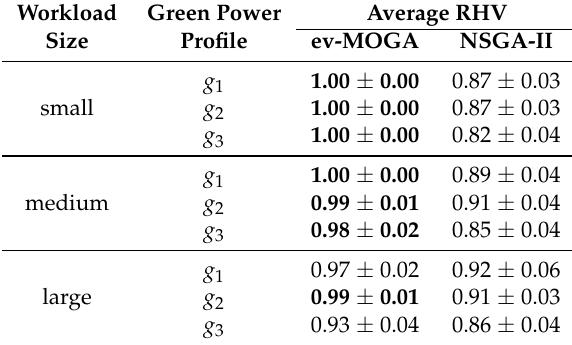
Table 3. Average and standard deviation of the relative hypervolume (RHV) for the best aggregated Pareto front computed by each algorithm for each workload size and green power generation profile.